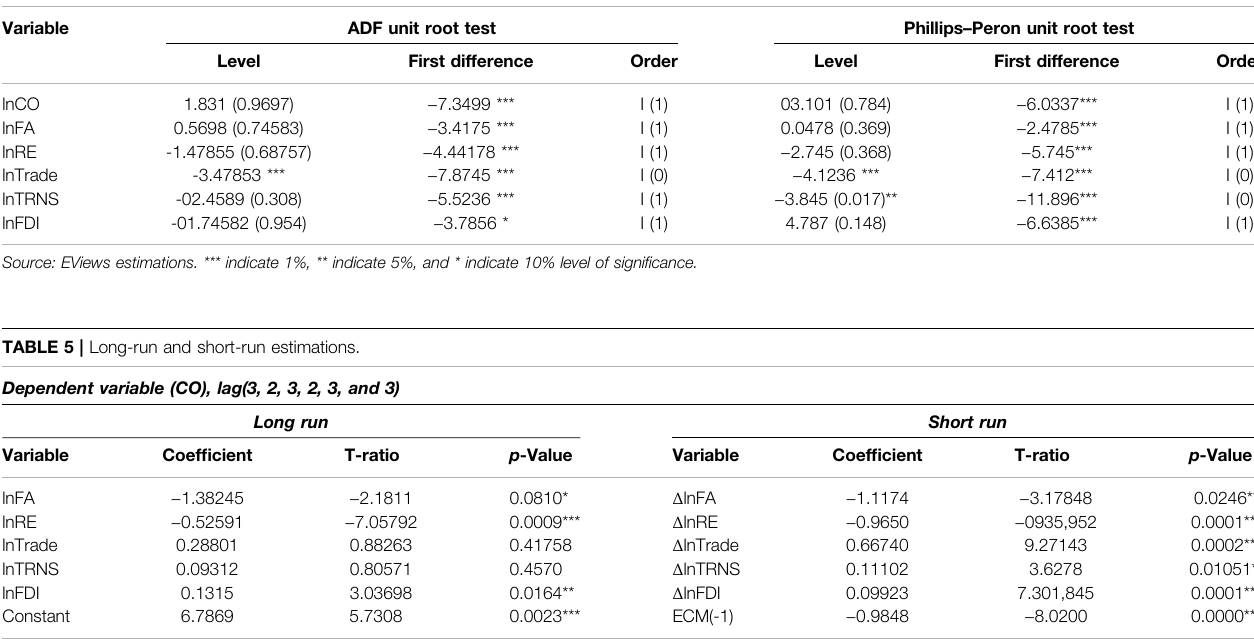
TABLE 4 | Unit root test.